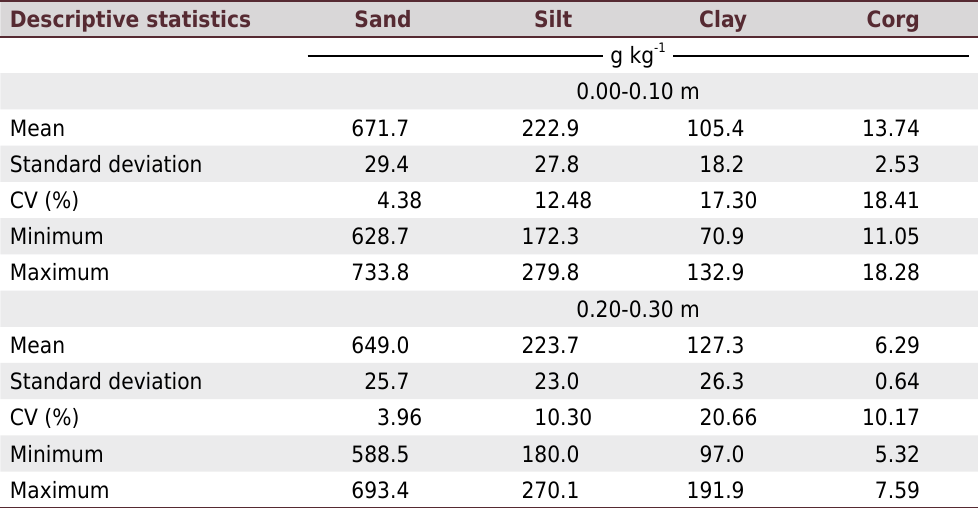
Granulometry determined according to Gee and Bauder (1986) and Suzuki et al. (2015). Organic carbon (Corg) was quantified by the wet combustion method (Nelson and Sommers, 1982) and by the Mebius procedure in